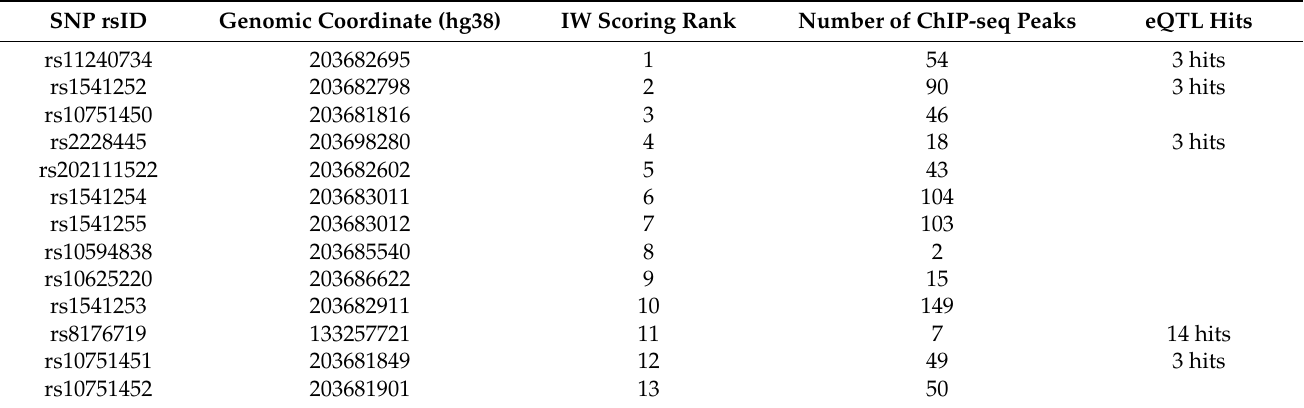
Table 1. Numbers of transcription factor ChIP seq peaks and IW scoring rank for the promising